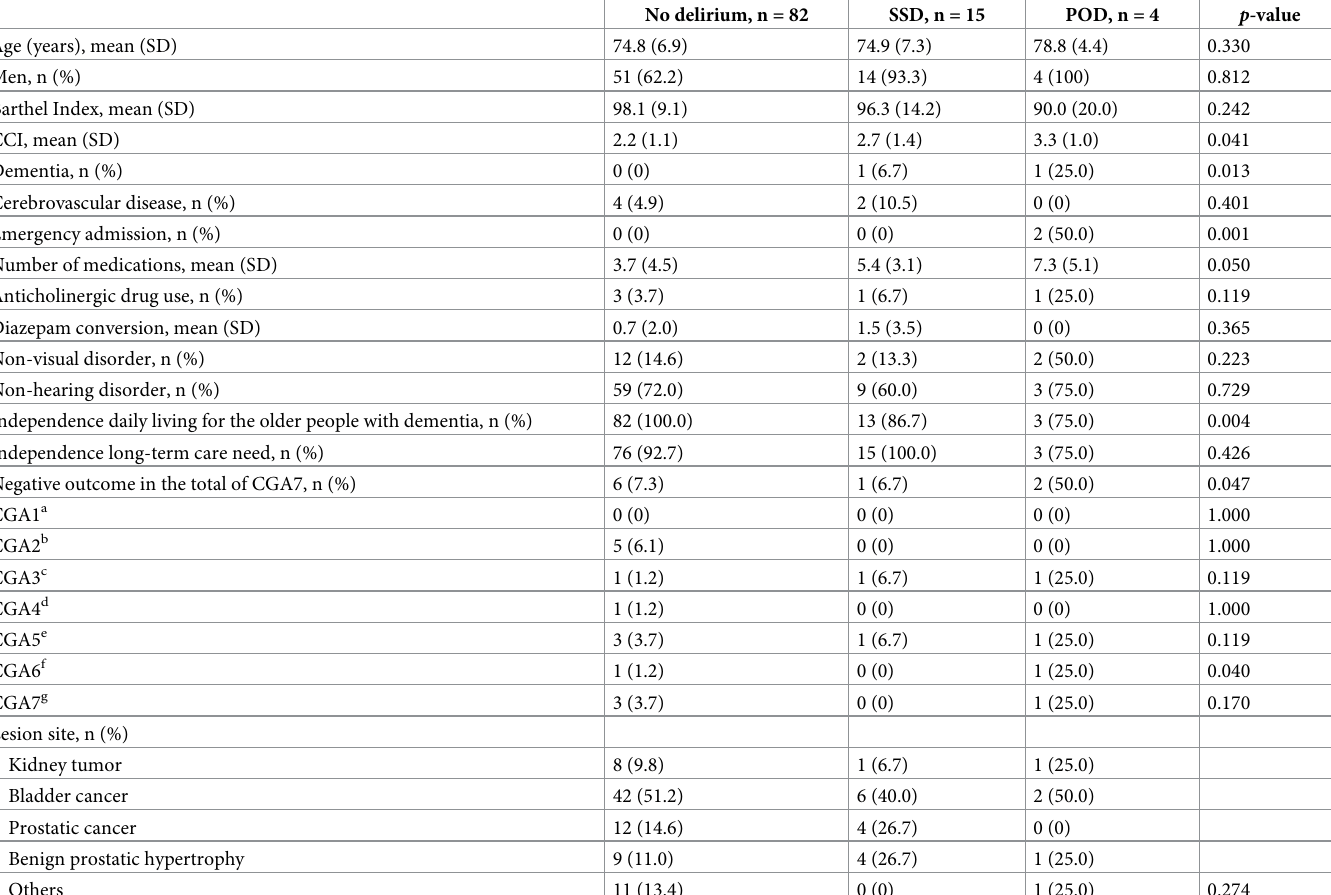
Table 5. Differences in demographic characteristics (no delirium vs. SSD vs.